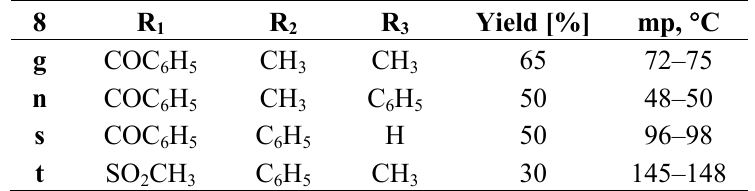
Table 6. Formation of